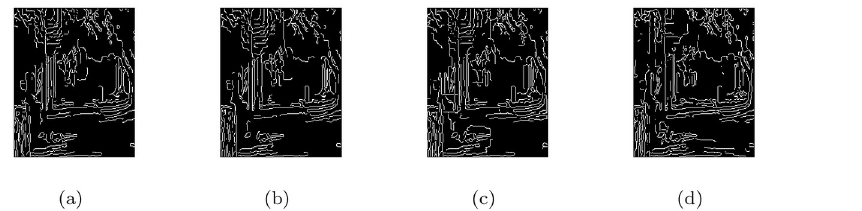
Fig 16. Related visible edge maps of Fig 15.